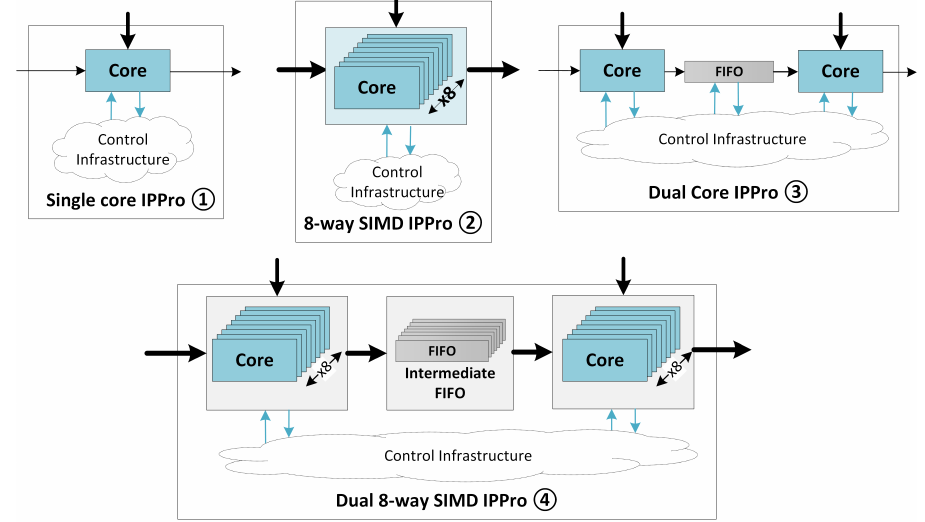
Figure 11. IPPro-based hardware accelerator designs to explore and analyse the impact of parallelism on area and performance based on Single core IPPro 1 (cid:13) , eight-way parallel SIMD IPPro 2 (cid:13) , parallel Dual core IPPro 3 (cid:13) and combined Dual core 8-way SIMD IPPro called 4 (cid:13)